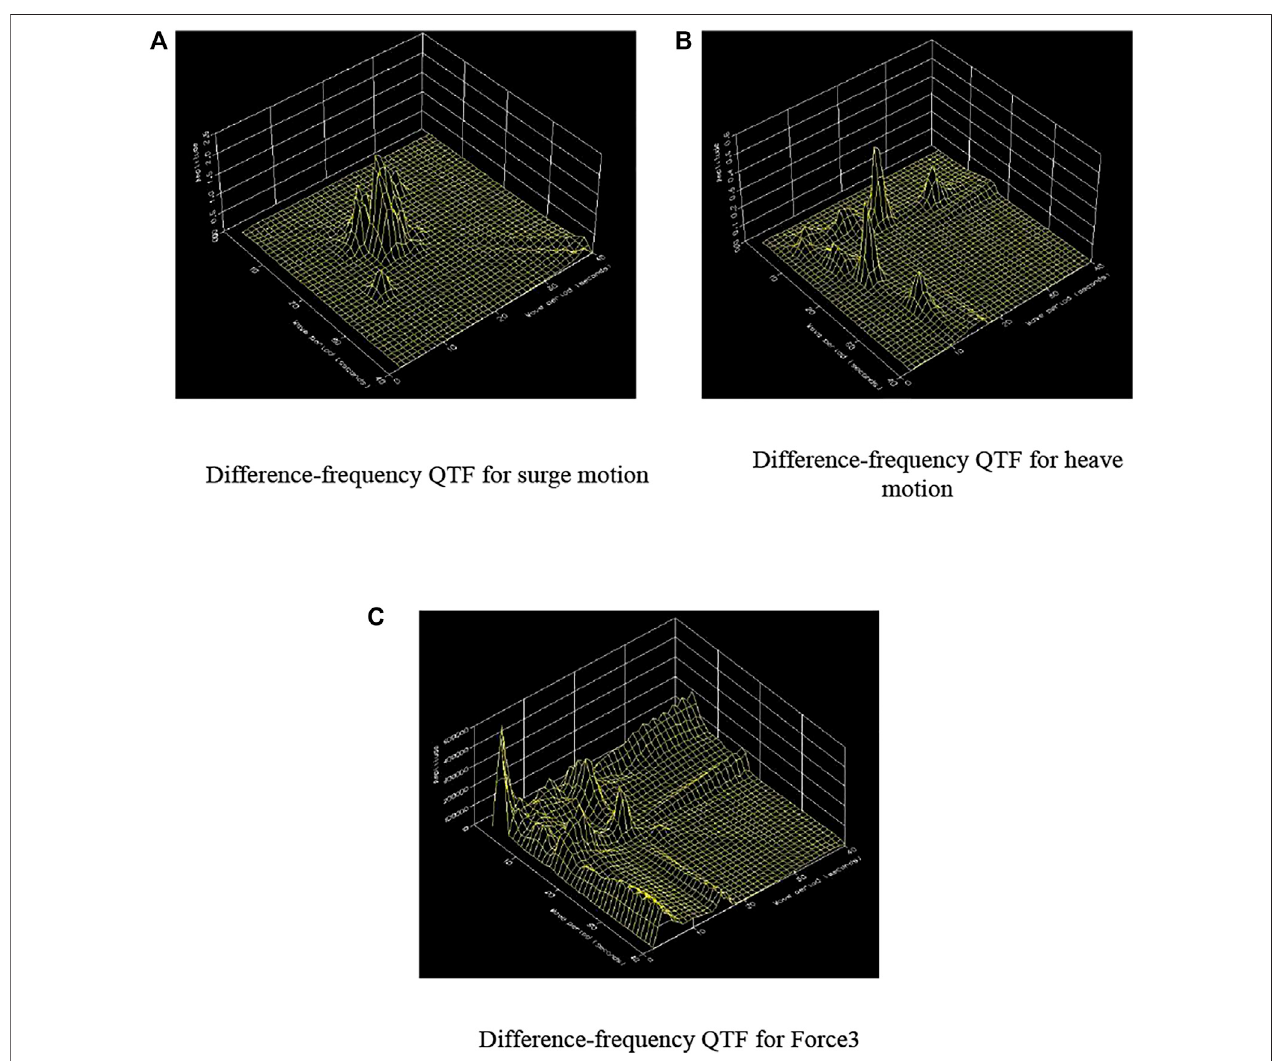
FIGURE 6 | QTF of the semi-submersible platform with the zero-degree incoming wave direction. (A) Difference-frequency QTF for surge motion. (B) Difference- frequency QTF for heave motion. (C) Difference-frequency QTF for Force 3.